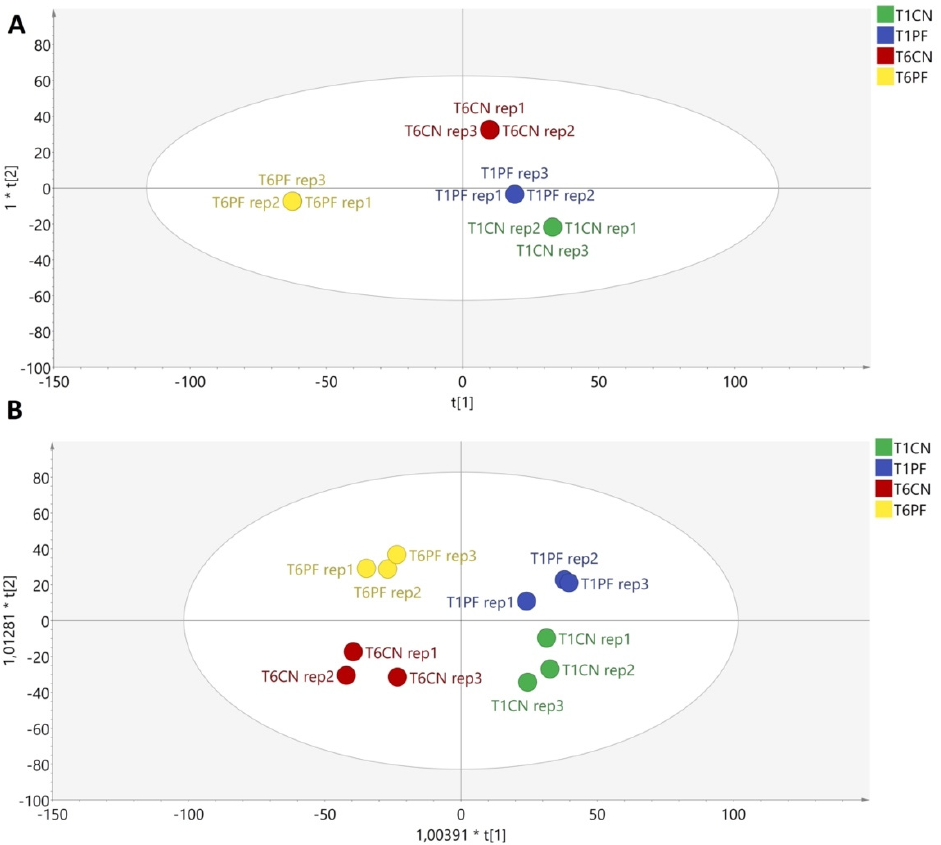
Table 2. Goodness-of-fit parameters of the OPLS-DA models built.